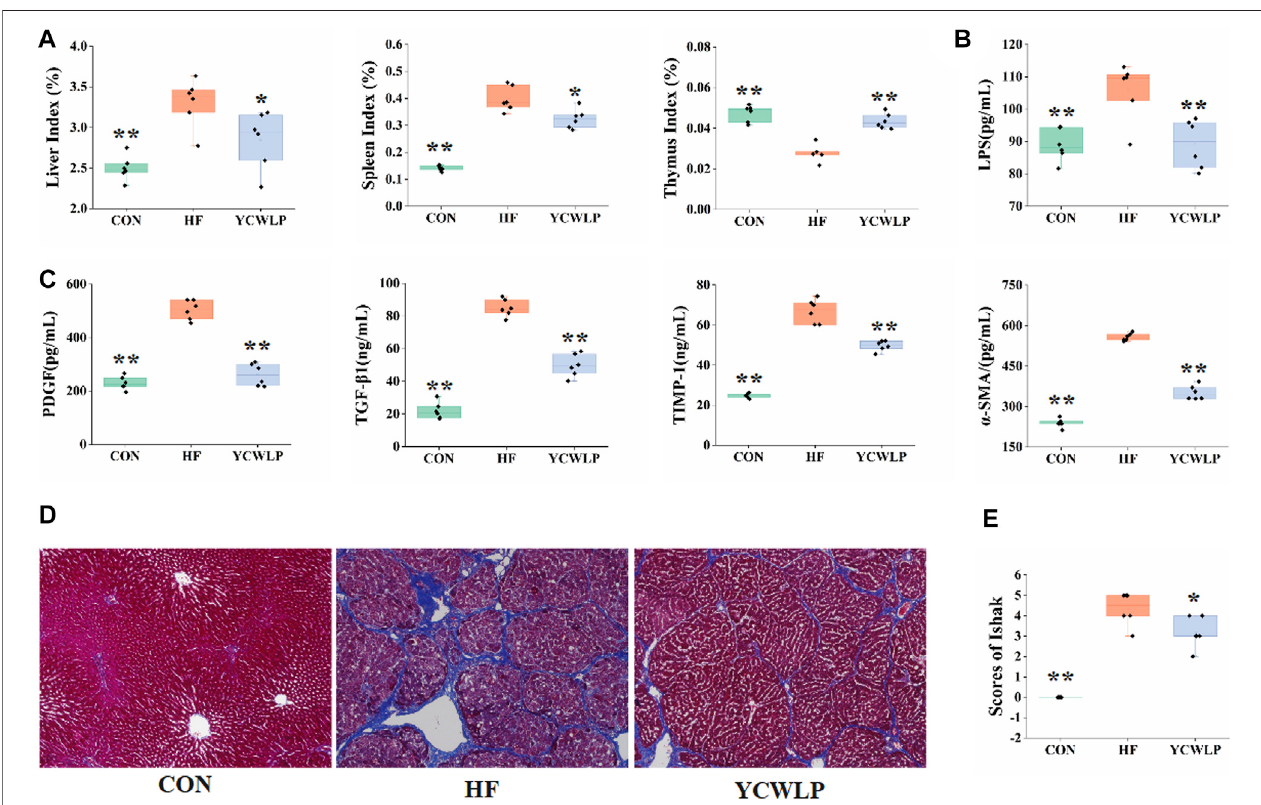
FIGURE 1 | Effect of YCWLP on the CCl 4 − induced HF ( n (cid:1) 6). (A) Liver, spleen and thymus indices; (B) LPS in the plasma samples; (C) The expression of PDGF, TGF- β 1, TIMP-1 and α -SMA in the liver samples. (D) Masson ’ s trichrome staining of rat liver tissue. Magni fi cation × 100; (E) Ishak scores based on Masson ’ s trichrome staining of rat liver tissue. Signi fi cant difference compared with the HF group: * p -value < 0.05; ** p -value < 0.01.